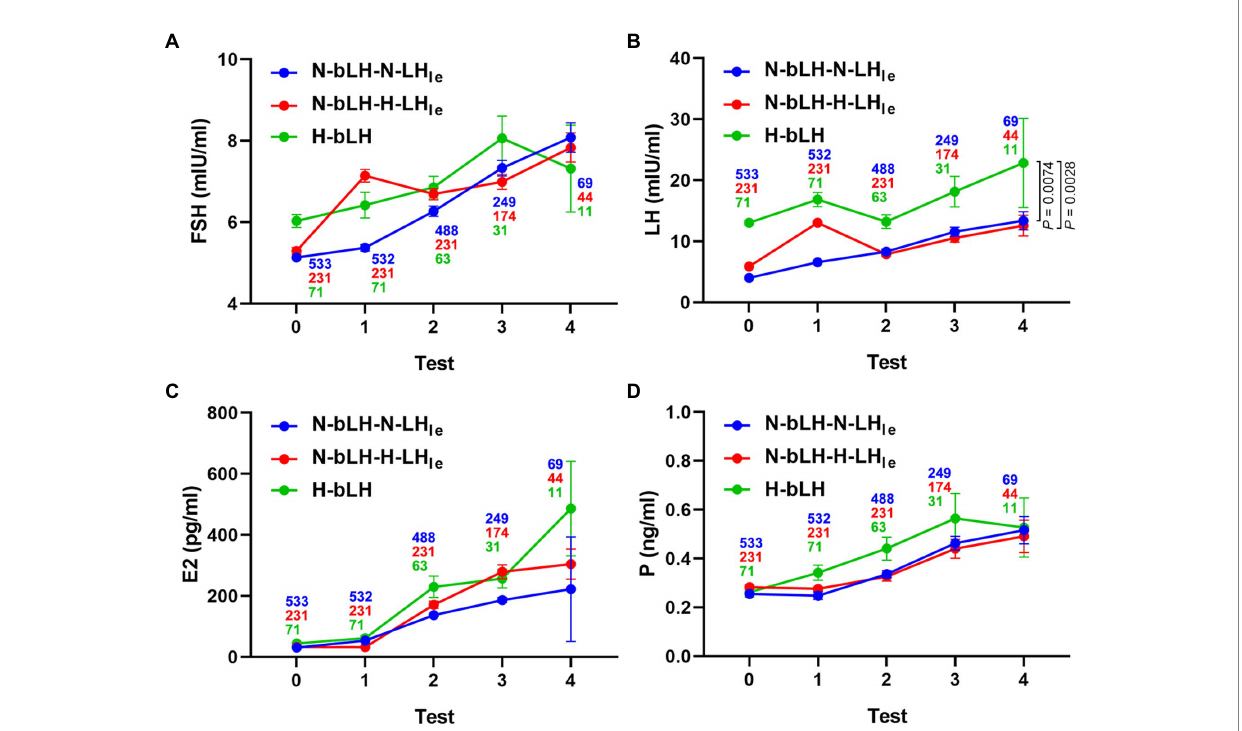
FIGURE 1 Hormone profile of different LH groups during ovulation induction with letrozole. (A) Serum FSH level. (B) Serum LH level. (C) Serum E2 level. (D) Serum P level. Test 0 indicates the basal hormone levels. Test 1 refers to the hormone levels following LE treatment for 5 days. In tests 2, 3, and 4, hormone levels were measured several times until the trigger